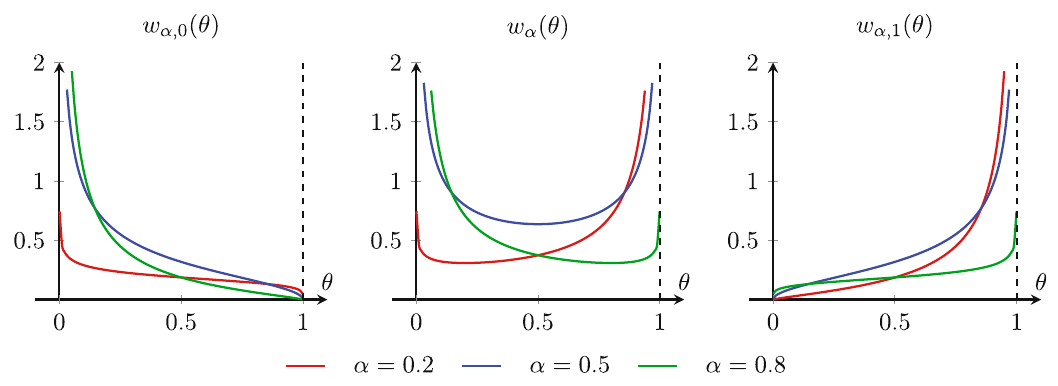
Figure 2: Depiction of the kernels w α ,0 ( left ) , w α ( middle ) , and w α ,1 ( right )